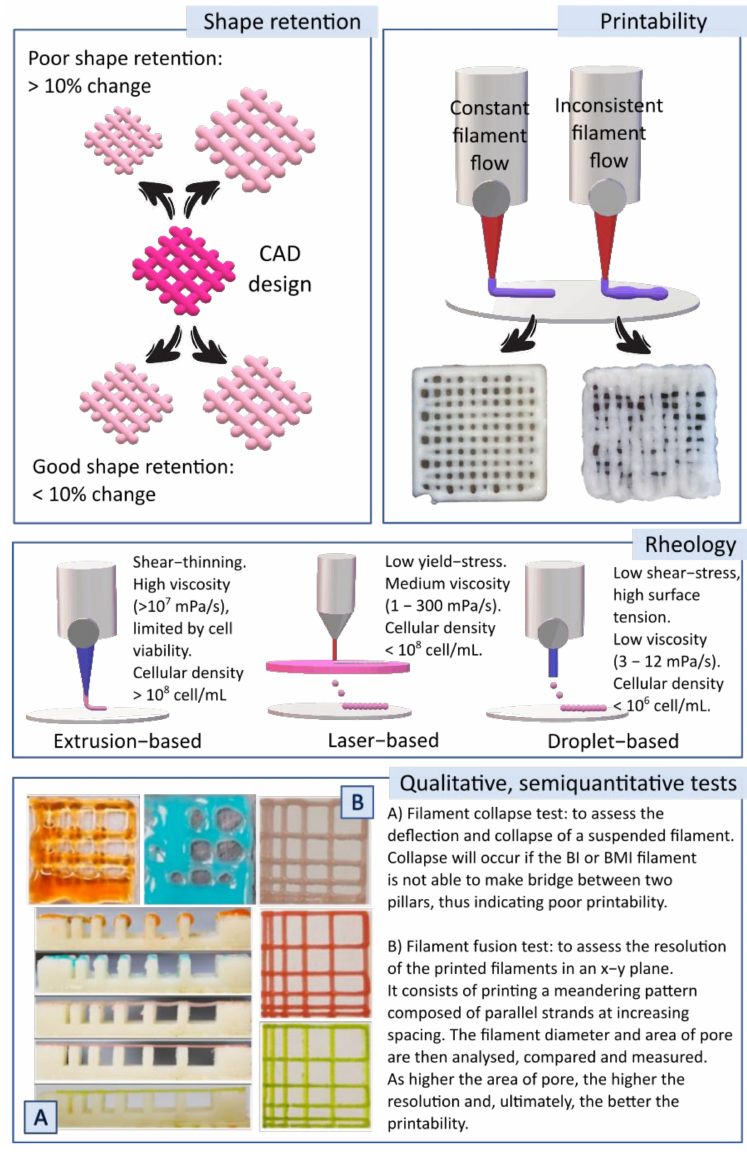
Figure 8. Up: schematic representation of “printability” and “shape fidelity” or “shape retention” concepts. Middle: summary of some desirable rheological properties of BI and BMI based on three 3DBP techniques (extrusion-based, laser-based and droplet-based). High viscosities are acceptable